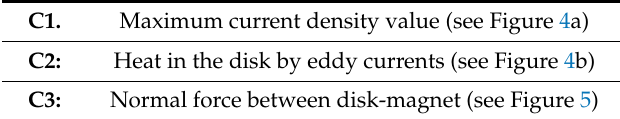
Table 1. Numerical experiments